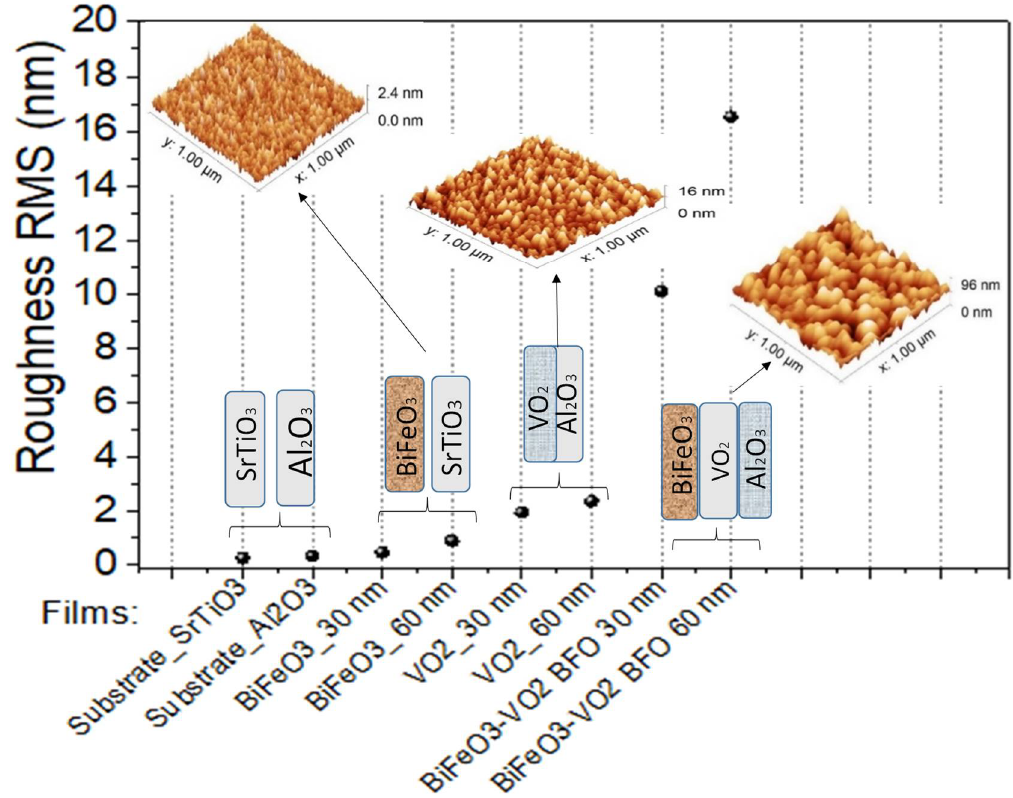
Figure 8. Roughness of films based on BFO and VO 2 .